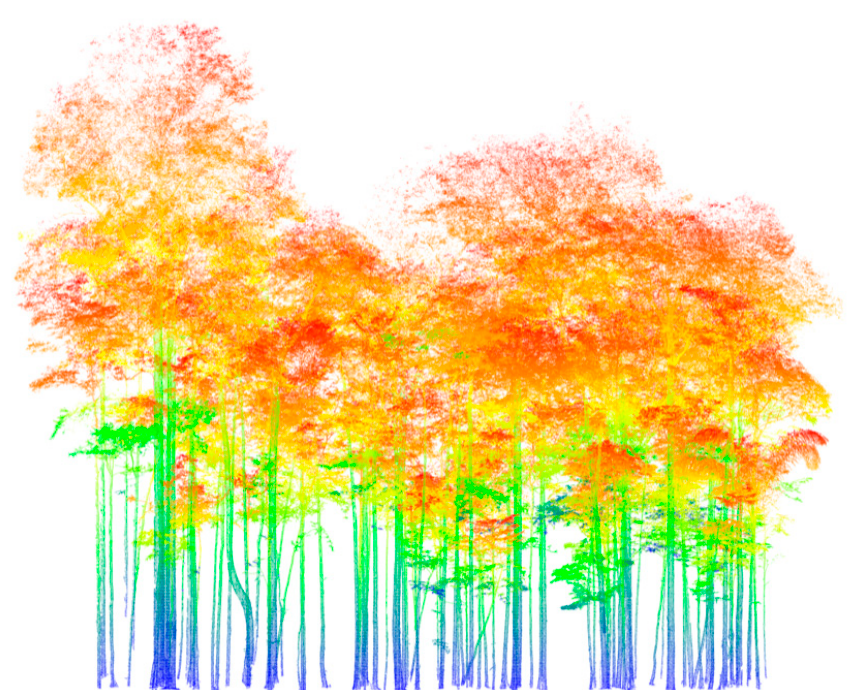
Figure 3. Example imagery of terrestrial laser scanning conducted in an eastern-central Amazonian terra-firme forest using a RIEGL VZ400. Differences in laser beam density are color-coded blue to red from high to low reflection density.